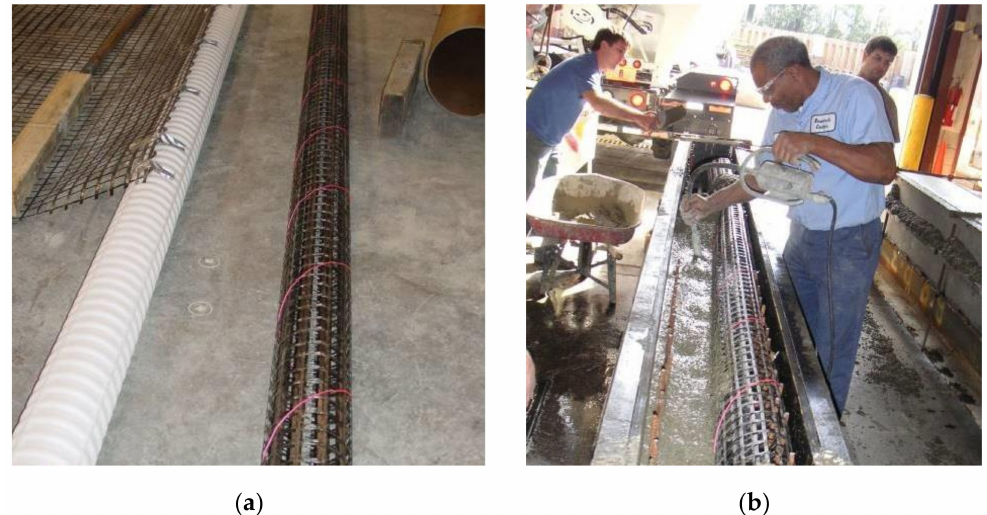
Figure 11. ( a ) Tube (coil) of CFRP grid formed using a plastic pipe held in place by a string, and ( b ) concrete casting of the tube beam (initially only 1 CFRP tube (coil) was placed to facilitate concrete pouring and leave space for the use of a